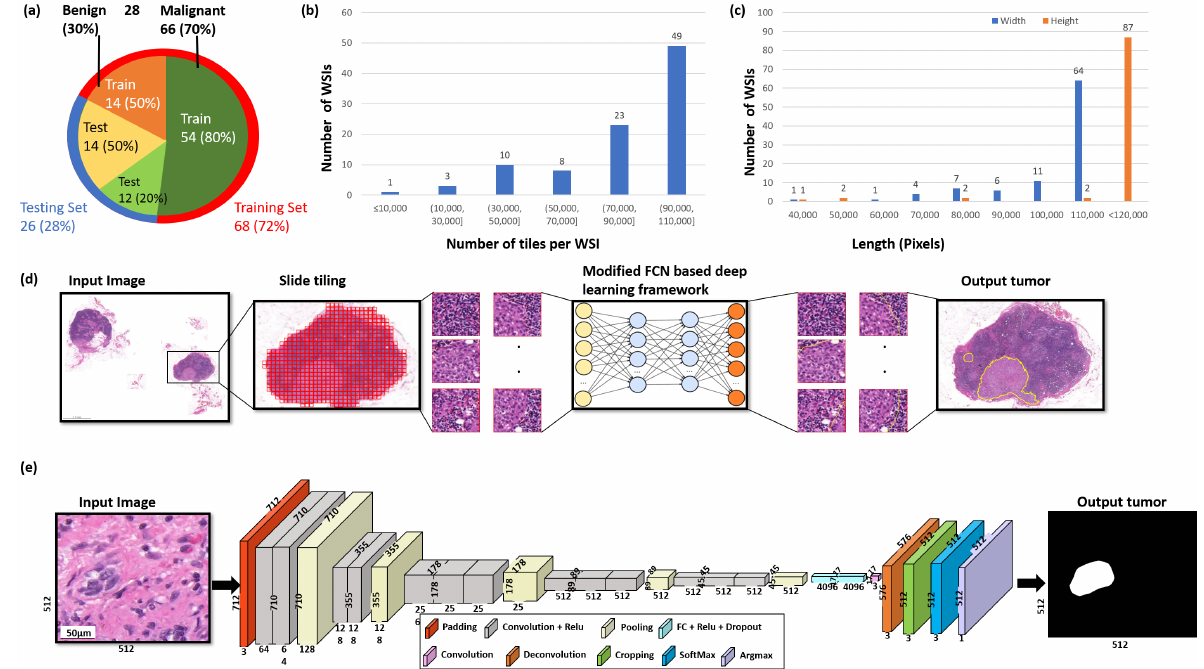
Figure 2. The overview of the data and the proposed deep learning framework presented in this study. ( a ) Distribution of data between malignant and benign samples and for training and testing data, respectively. ( b ) The number of tiles delivered per WSI. ( c ) The width and height distributions of the WSIs are shown in blue and orange, respectively. ( d ) The proposed deep learning framework for the segmentation of breast cancer. Firstly, Otsu’s method is used to threshold the slide image to efficiently discard all background noise. Secondly, each WSI is formatted into a tile-based data structure. Thirdly, the tiles are then analyzed by a deep convolutional neural network to produce the breast cancer metastasis segmentation results. ( e ) Illustration of the proposed modified FCN